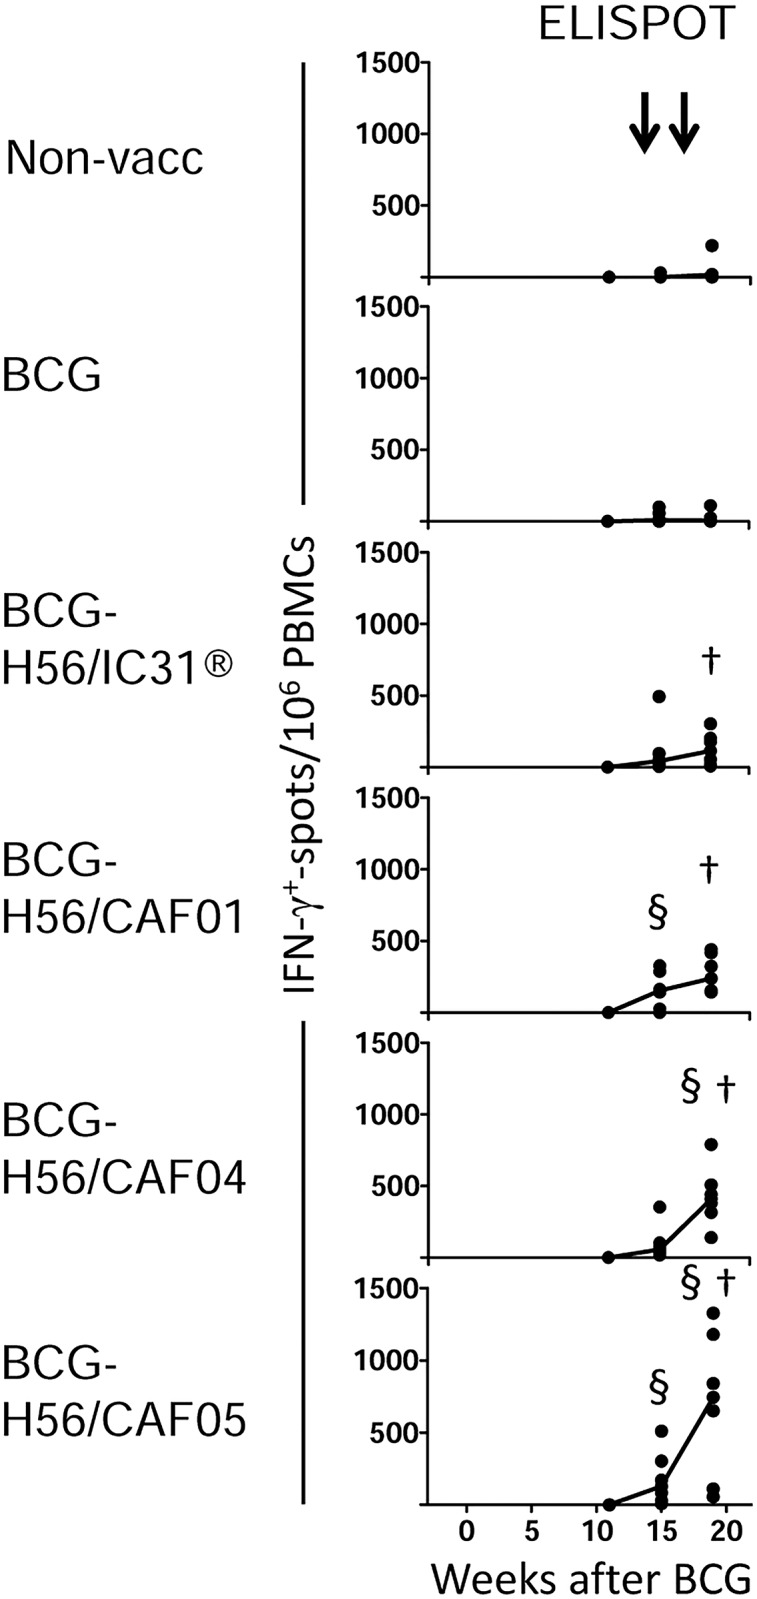
Boosting BCG with H56 in four cationic adjuvants induces vaccine-specific proliferation and IFN-γ production.Monkeys were immunized and bled as depicted in Fig 1, timing of BCG and H56 boosters are indicated with arrows above the panels. The number of IFN-γ producing cells in PBMCs assessed by ELISPOT after H56 stimulation in vitro at the indicated time points in duplicate cultures. Note ELISPOT baseline was at week -11. Dots depict background-subtracted responses of individual monkeys; medians are indicated with a solid line. Medians for non-vaccinated and BCG groups were zero. †, denotes significant difference compared to baseline within group. §, denotes significant difference compared to non-vaccinated at the same time point. See text for p-values.